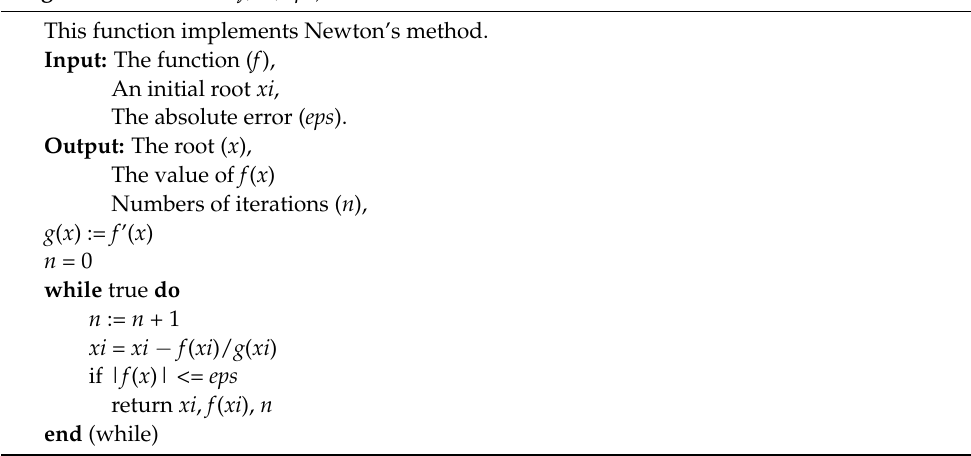
Algorithm 4. Newton( f , xi , eps ).